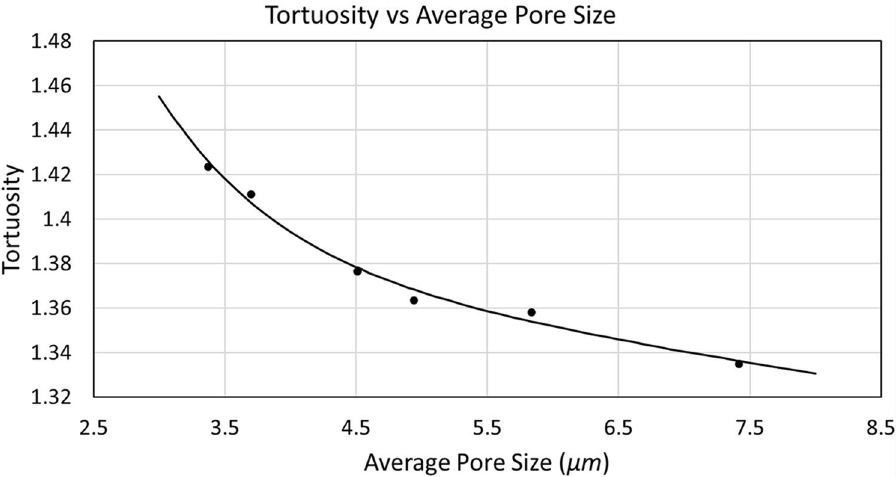
Figure 19. The continuous black line corresponds to the fitting function of the tortuosity depending on the average pore size for the porous media.